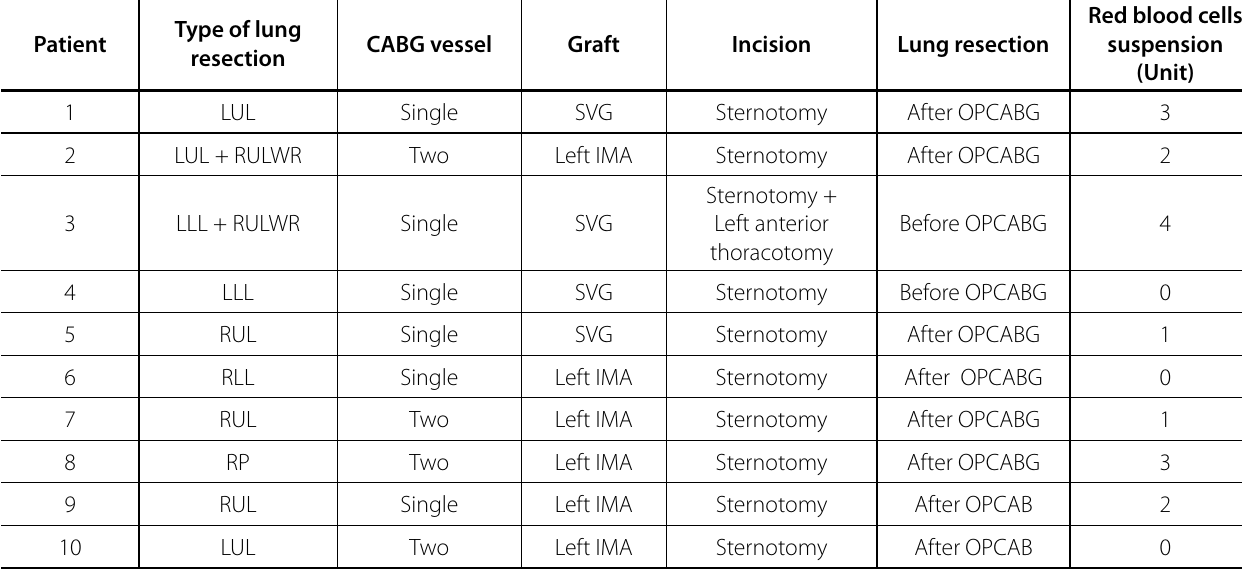
Table 2. Operative data of the